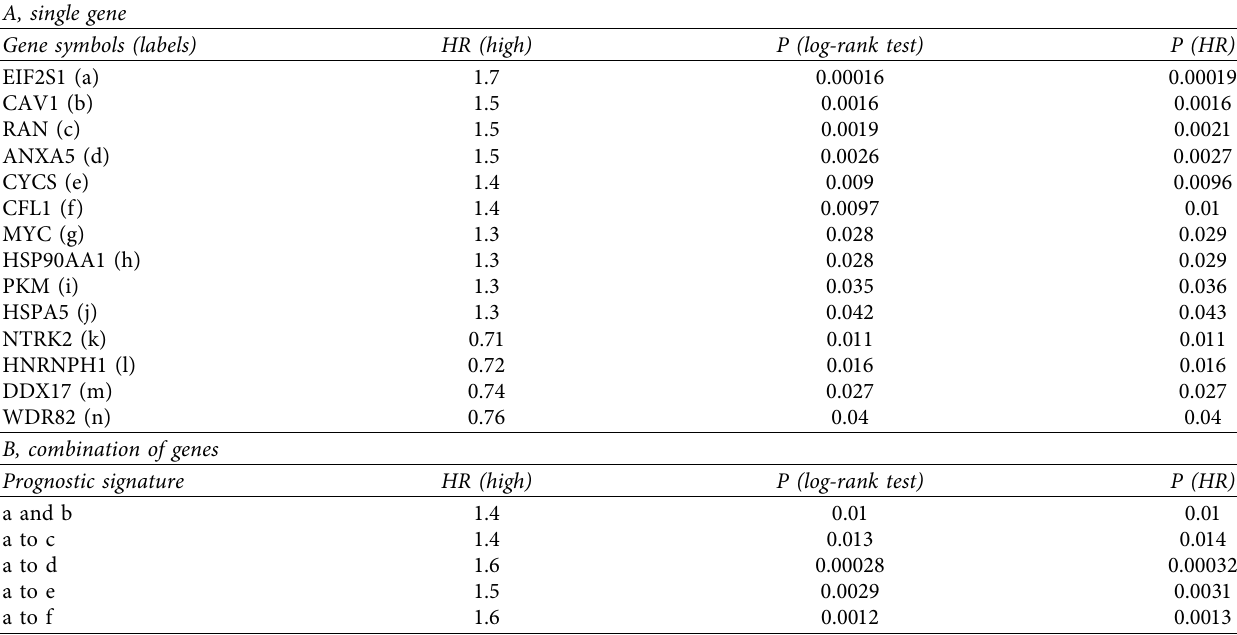
Figure 5: A connected PPI network based on the hub genes. Violet and green circles represent negative and positive markers in HNSCC, respectively. PPI, protein-protein interaction network; HNSCC, head and neck squamous cell carcinoma. Table 3: A total of 14 hub genes in the PIM associated with the etiology of OTSCC and BSCC were revealed to be prognostic markers in